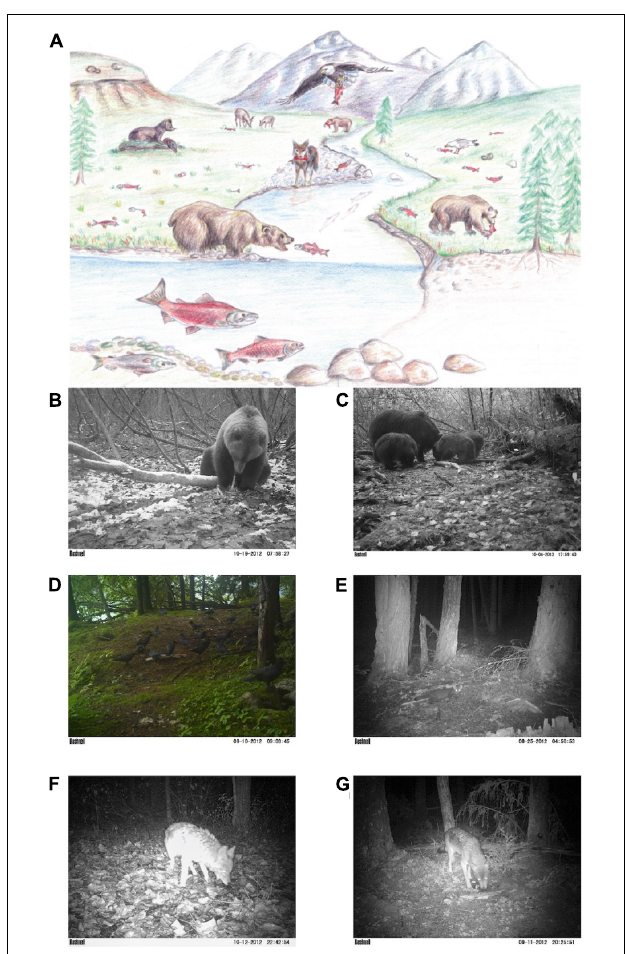
FIGURE 2 | Mature salmon (A) reach terrestrial and aquatic systems where they are the dominant prey of bears. By leaving uneaten carcass remains in riparian areas, bears serve as vectors of salmon to terrestrial and aquatic systems, supplying nutrients and food to riparian vegetation, invertebrates, and vertebrate scavengers (Source: Levi et al., 2012). (B–G) Recorded images of wildlife consumption of individual salmon carcasses at camera trap stations from Levi et al., 2015. A wide variety of species were observed feeding on salmon carcasses, including brown bears (B,C) , eagles, ravens, crows (D) , mink, marten (E) , coyotes (F) , and wolves (G)